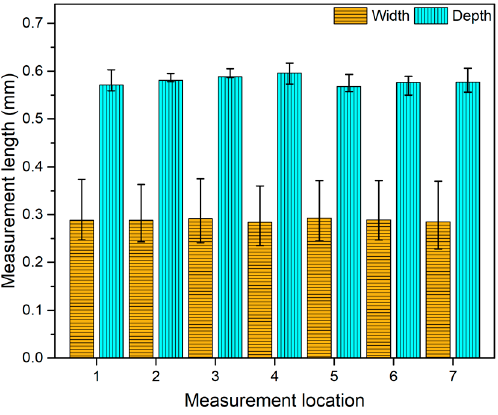
Figure 9. Dimension of channel width and depth of PBF-built SUS 316L BP.